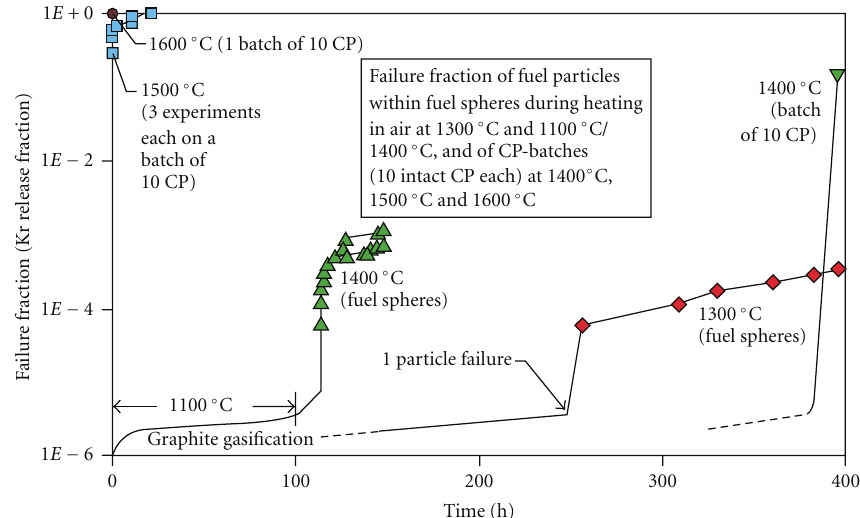
Figure 10: KORA results on behaviour of TRISO fuel elements and on batches of 10 coated particles (CP) disintegrated from fuel elements in